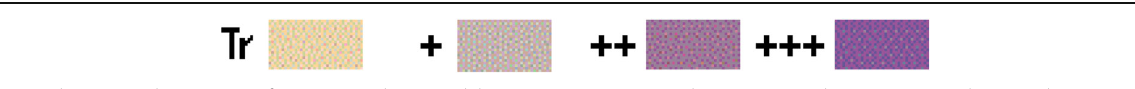
Fig. 1 title: How to diagnose an infection using the Dipstick bar. Tr = Trace, (+) = One plus, (++) = two plus, (+++) = tree plus. Tr and (+) are considered as negative results. (++) and (+++) are considered as positive results